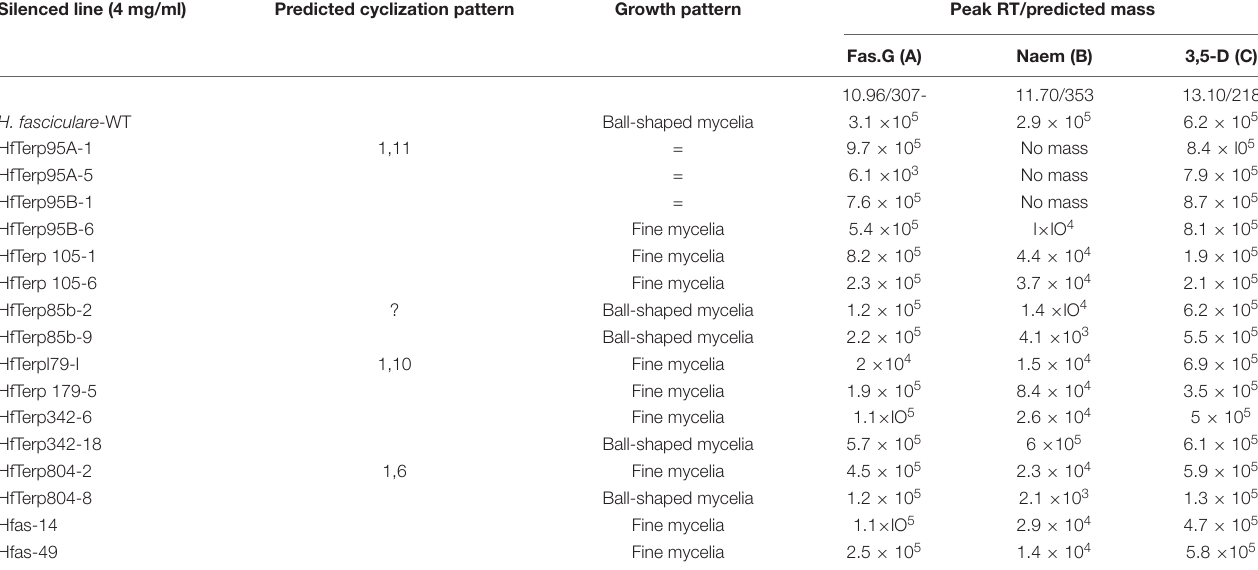
TABLE 4 | Growth pattern and mass detector response count per second of two selected putative antisense transformants for each silenced line alongside the wild type. Silenced line (4 mg/ml)